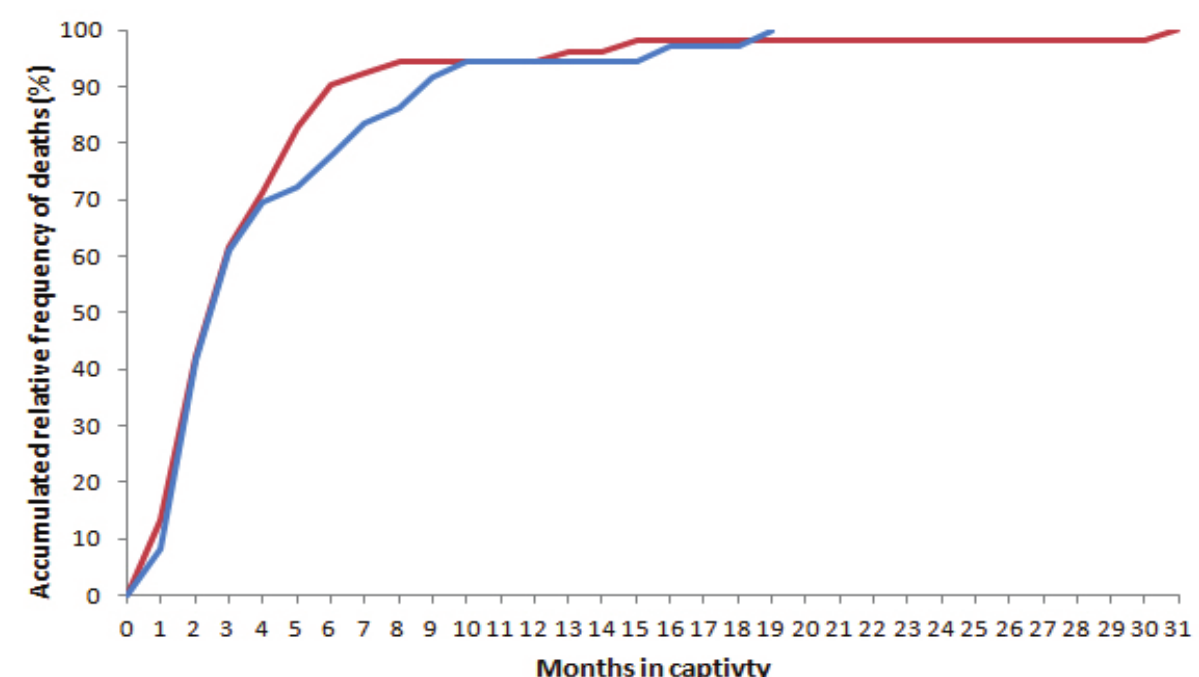
Figure 3. Mortality curves for captive Philodryas olfersii (blue line) and Philodryas patagoniensis (red line) after admission in